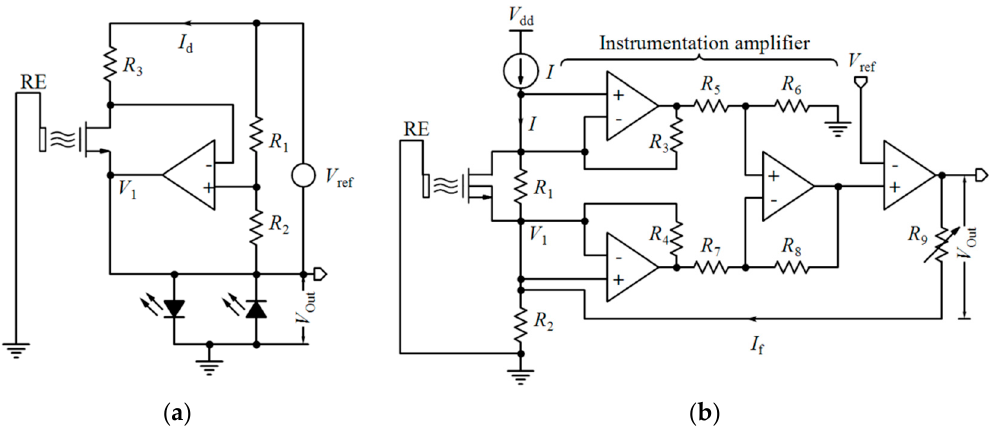
Figure 24. ( a ) A basic diagram of a source/drain follower readout circuit; ( b ) an ISFET amplifier proposed by Bergveld et